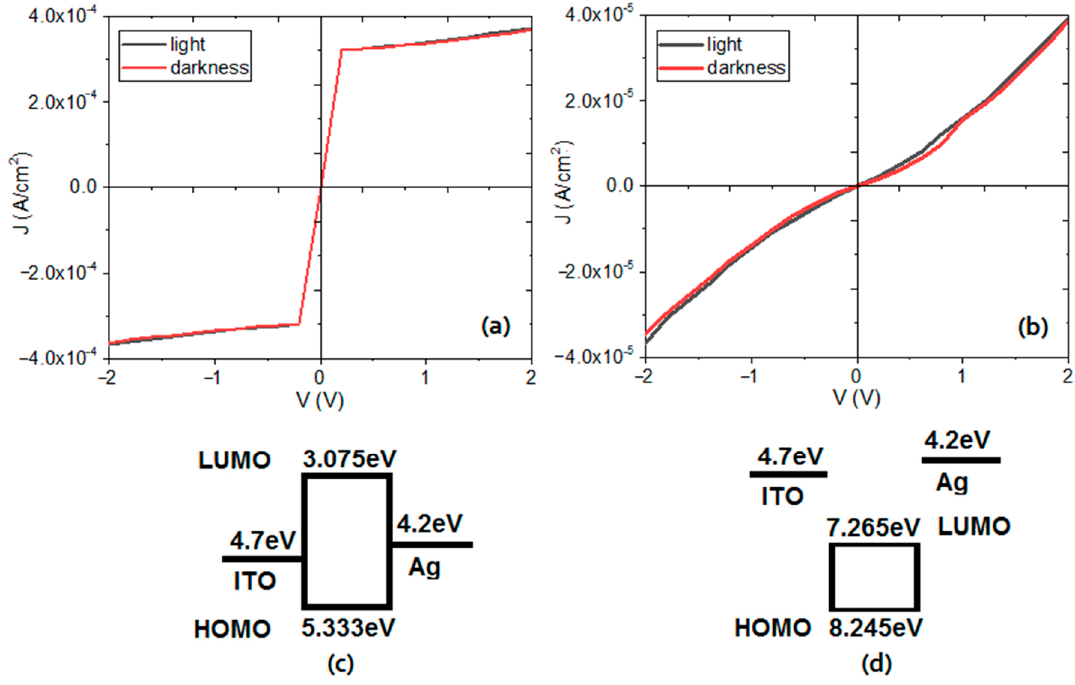
Figure 9. J-V plots and energetic diagrams for the ( a , c ) CoPc-TCNQ and ( b , d ) CoOEP-TCNQ flexible devices. flexible